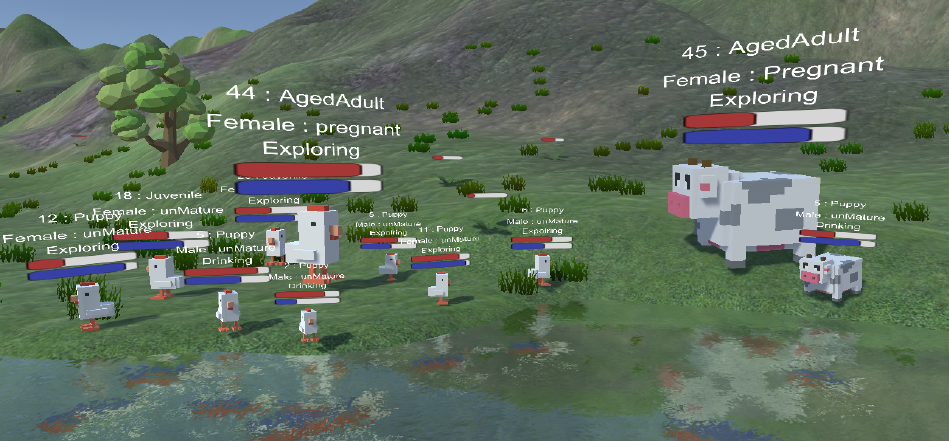
Figure 13. Animals with a faster reproduction rate create much more offspring than a usually bigger animal with longer pregnancy